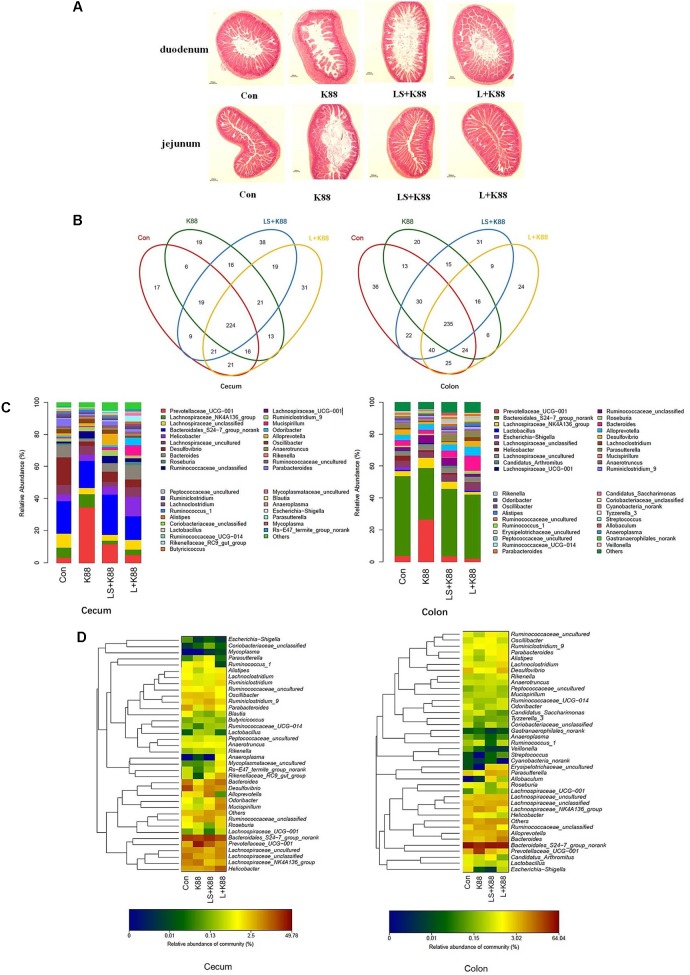
Modulatory effects of L. casei 393 and L. casei 393-SeNPs on the intestinal morphology and microbiome in mice challenged by ETEC K88. (A) The histology of duodenum and jejunum. (B) Shared OUT analysis of the different libraries. Venn diagram showing the unique and shared OTUs (3% distance level) in the different libraries. (C) Bacterial composition of the different communities. Relative read abundance of different bacterial genus within the different communities. Sequences that could not be classified into any known group were assigned as “unclassified bacteria.” (D) Bacterial distribution for the cecum and colon libraries from different treatments. Double hierarchical dendrogram showing the bacterial distribution among the samples. The bacterial phylogenetic tree was calculated using the neighbor-joining method and the relationship among samples was determined by Bray distance and the complete clustering method. The heatmap plot depicts that the relative percentage of each bacterial family are depicted by color intensity with the legend indicated at the bottom of the figure. Clusters based on the distance of the four experimental treatments along the X-axis and the bacterial families along the Y-axis are indicated in the upper and left of the figure, respectively. K88 means the rats orally administrated with ETEC K88 only. LS + K88 means the rats pretreated with L. casei 393-SeNPs before administration with ETEC K88. L + K88 means the rats pretreated with L. casei 393 before administration with ETEC K88.